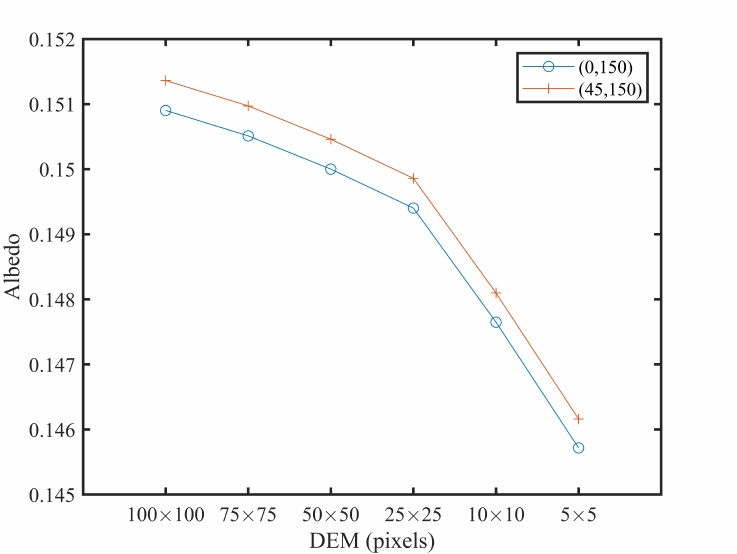
Figure 6. Albedo of multiscale DEMs based on the MRRT model under different illumination geometry: (0 ◦ , 150 ◦ ) and (45 ◦ , 150 ◦